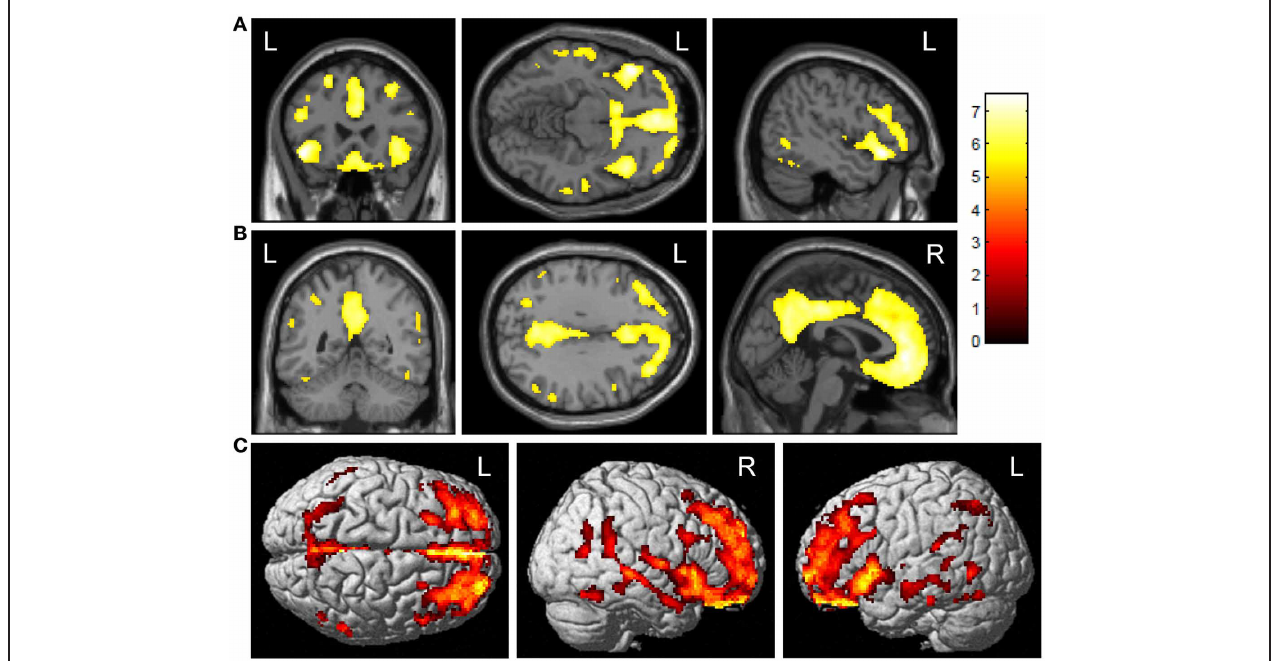
FIGURE 1 | Voxel-wise association of APOE ε 4 status and amyloid deposition in E-MCI participants. Greater cortical amyloid deposition was observed in APOE ε 4 + ( n = 85) relative to APOE ε 4 − ( n = 121) E-MCI participants. Significant clusters were observed in the medial and lateral frontal lobes (A) , anterior and posterior cingulate (B) , and lateral temporal